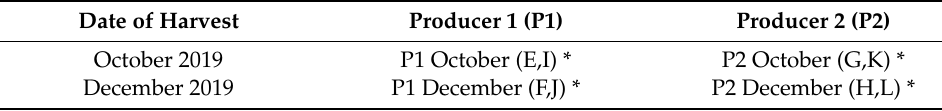
Table 3. Harvest periods and distillate codes for each